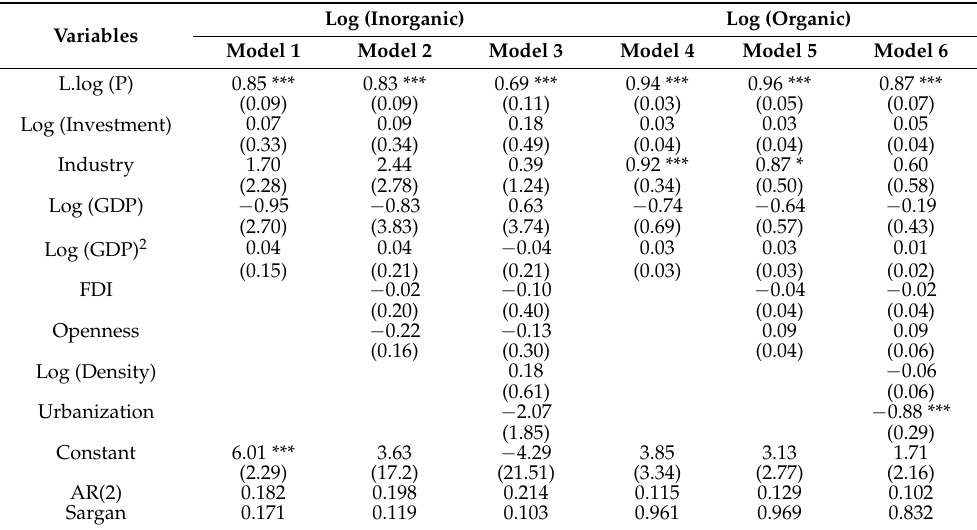
Table 4. Estimation Results of GMM